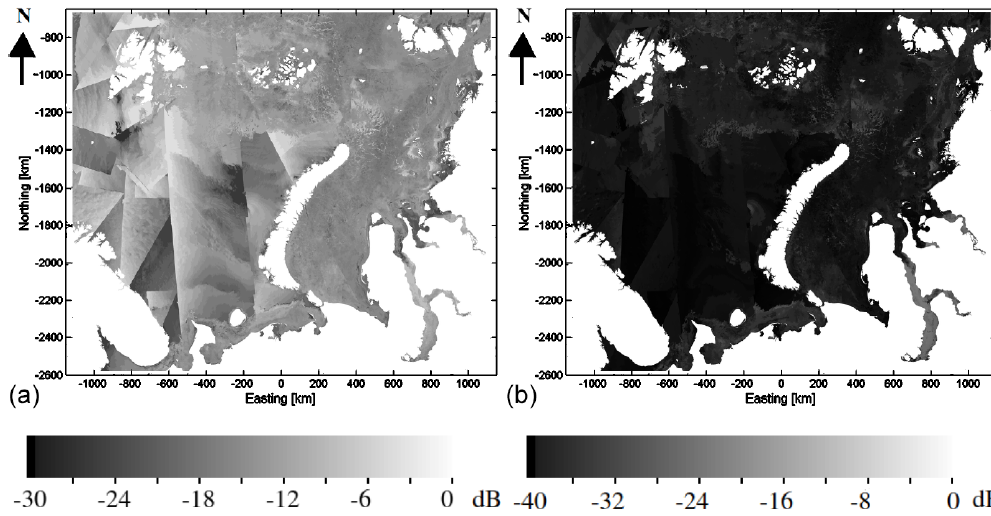
Figure 4. Sentinel-1 HH (a) and HV (b) mosaic σ 0 segment median on 21 February 2017.